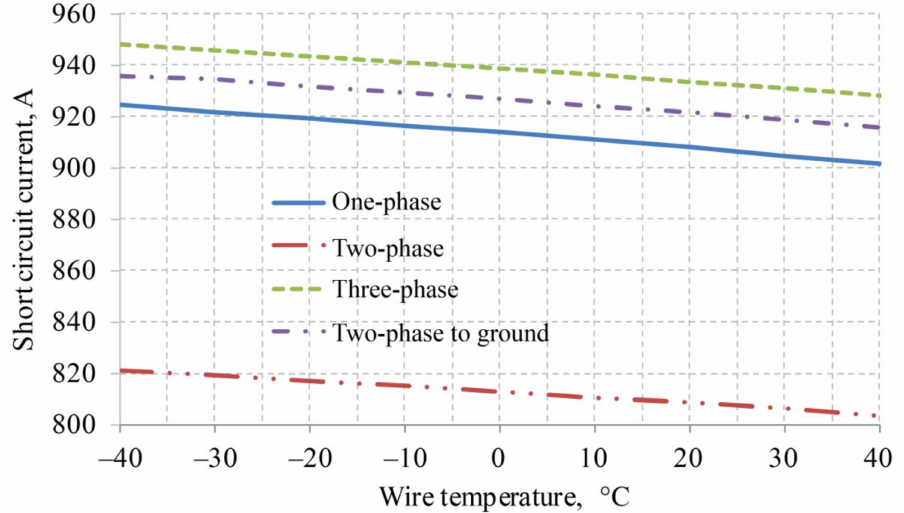
Figure 13. Relationship between the short-circuit current for various types of damage and the overhead line